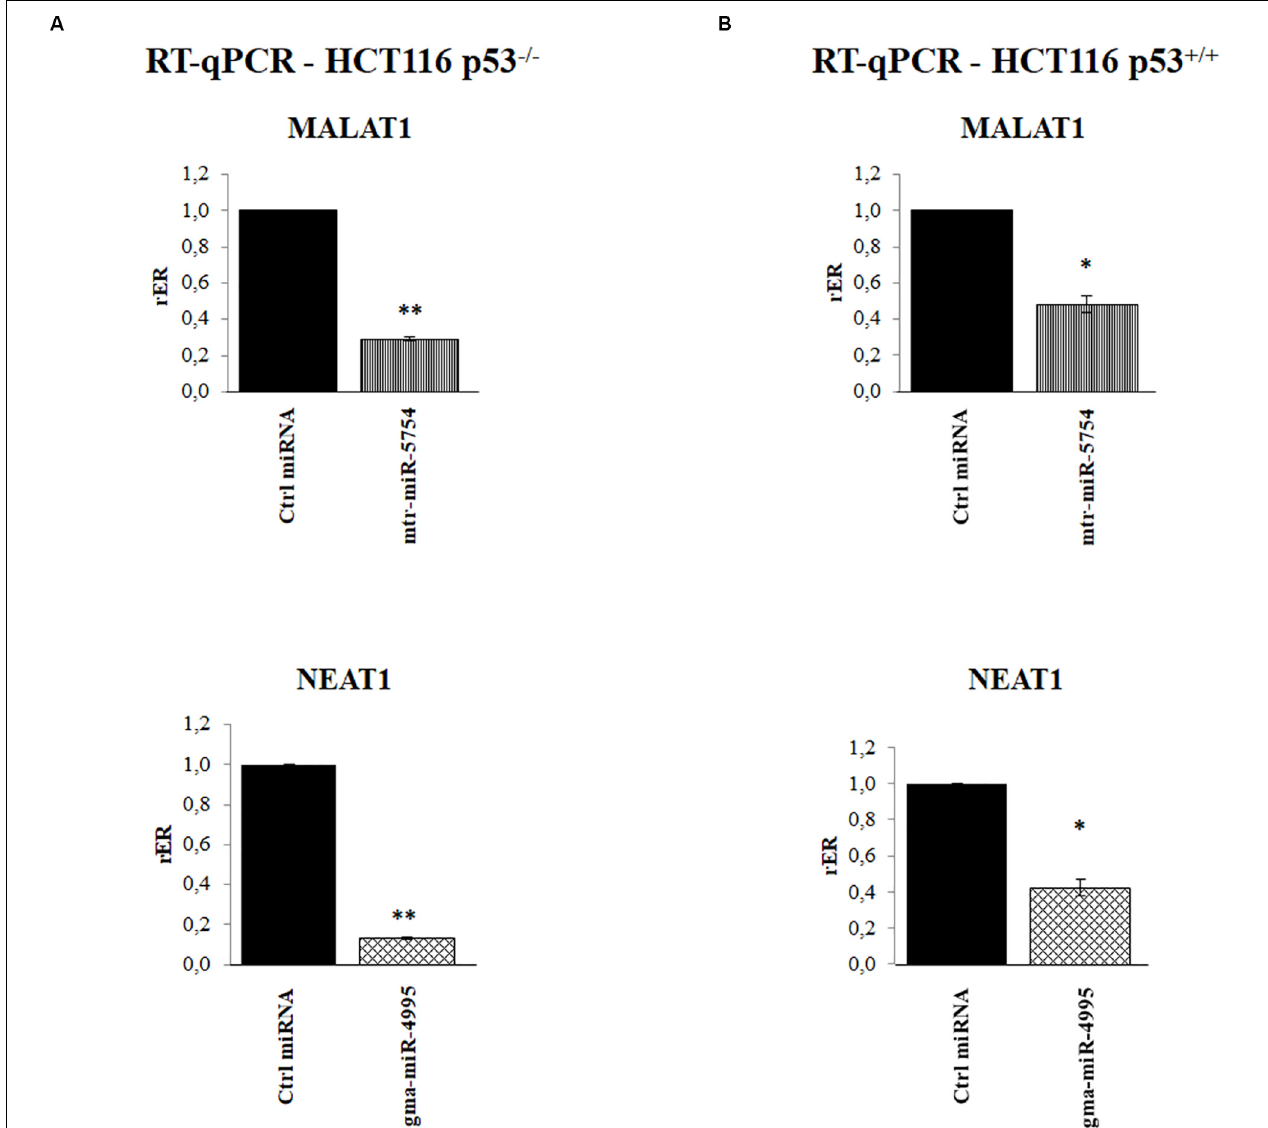
FIGURE 5 | Plant microRNAs (miRNAs) mtr-miR-5754 and gma-miR-4995 regulate metastasis-associated lung adenocarcinoma transcript 1 (MALAT1) and nuclear paraspeckle assembly transcript 1 (NEAT1) stability. (A,B) Reverse transcription quantitative PCR (RT-qPCR) of MALAT1 and NEAT1 long non-coding RNAs (lncRNAs) in HCT116 p53 − / − and HCT116 p53 + / + cell lines transfected with control miRNA, with mtr-miR-5754 or with gma-miR-4995 for 48 h. Data are shown as the average with a standard deviation of three independent experiments (* p < 0.05; ** p < 0.01).